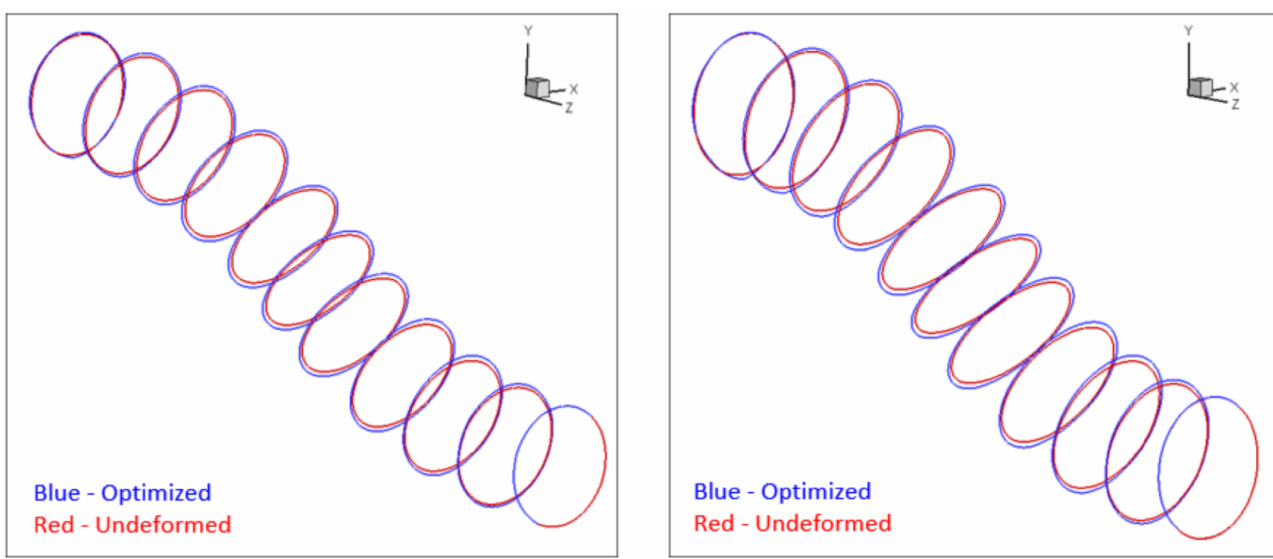
Figure 16. Cross-sectional comparison of the optimal distortion and PR ducts with an undeformed duct (left: optimal dist. (L = 12 m); right: optimal PR (L = 9 m)).